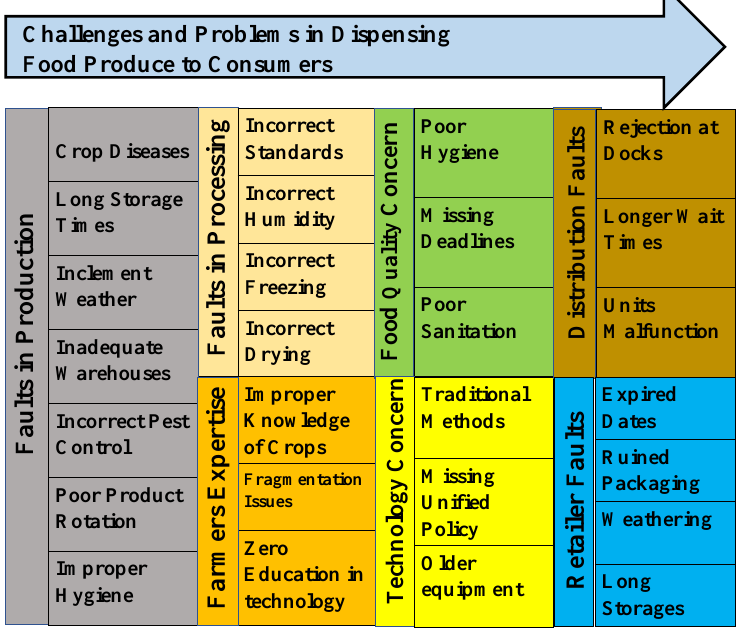
Figure 4. Concerns and challenges of agricultural production